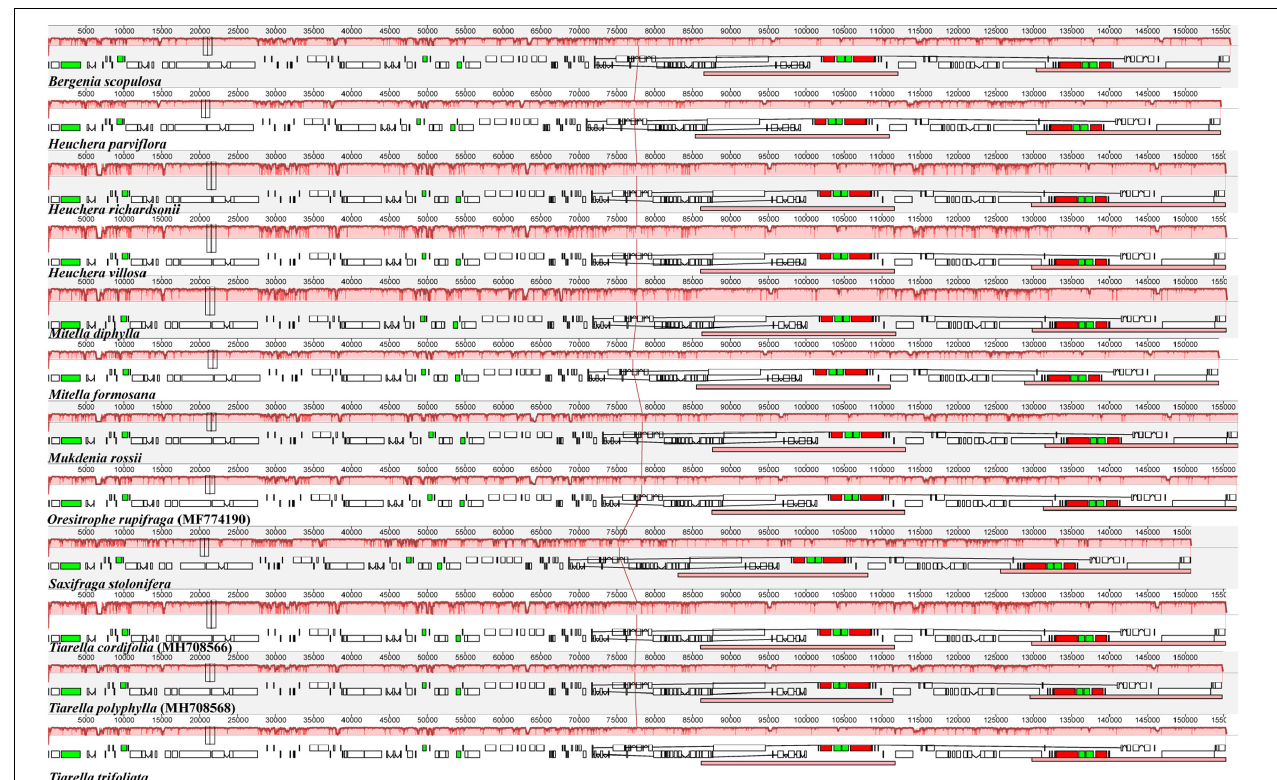
FIGURE 2 | Mauve alignment of 12 Saxifragaceae plastomes. Within each of the alignment, local collinear blocks are represented by blocks of the same color connected by lines.